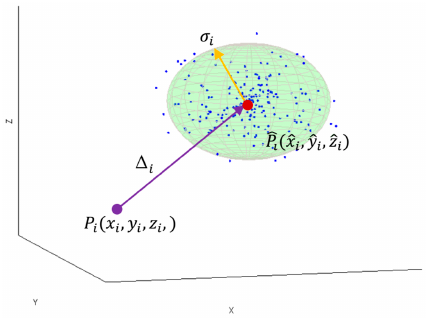
Figure 1. Illustration of 3D localization accuracy and precision for i -th tag’s position.